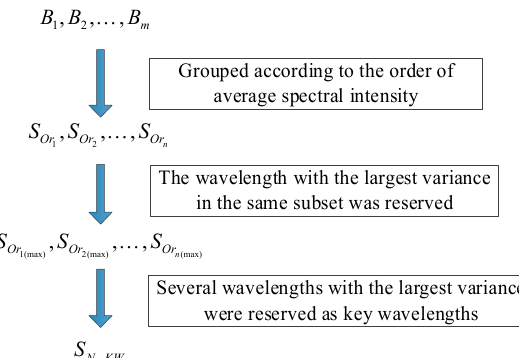
Figure 2. Flowchart of key wavelengths selection in this study.